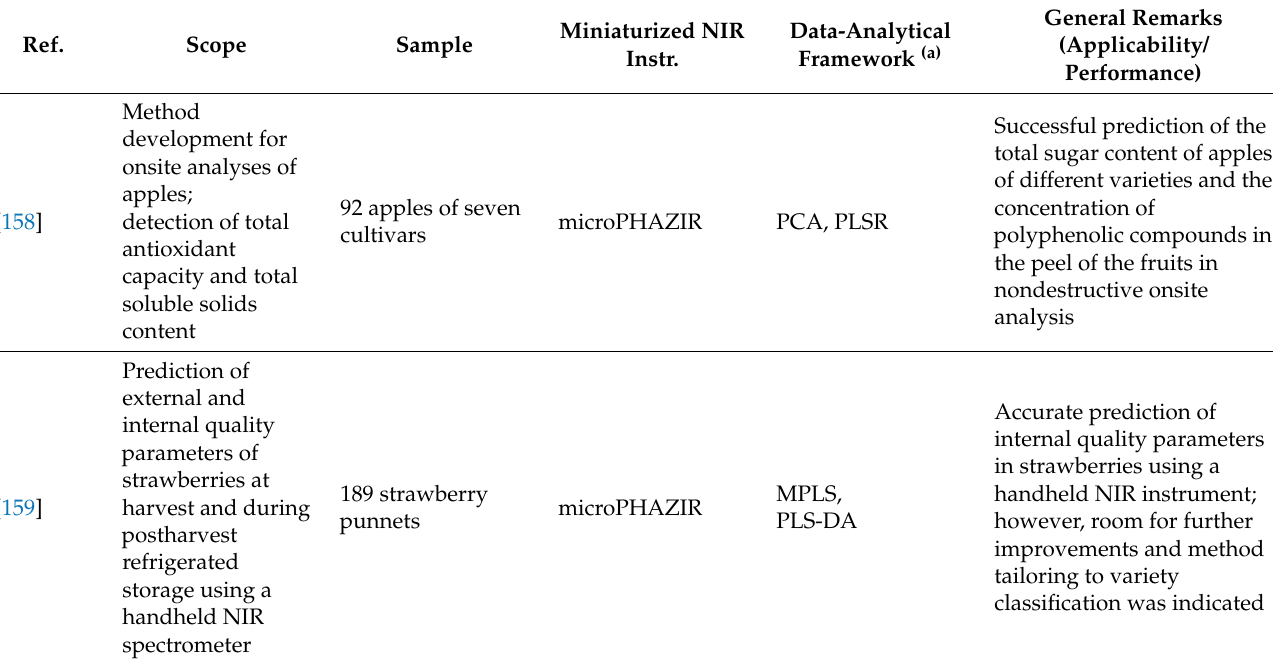
Table 7. Recent research activity oriented toward miniaturized NIR spectroscopy in the area of fruit and vegetable